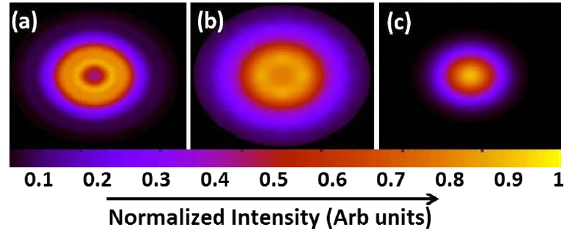
FIG. 8. Variation of outcoupled power as a function of wave- length for the confocal ( g ¼ 0 ), concentric ( g ¼ − 1 ), and inter- mediate ( g ¼ − 0 . 6 ) configurations. For a hole size of (a) 1 mm and (b) 4